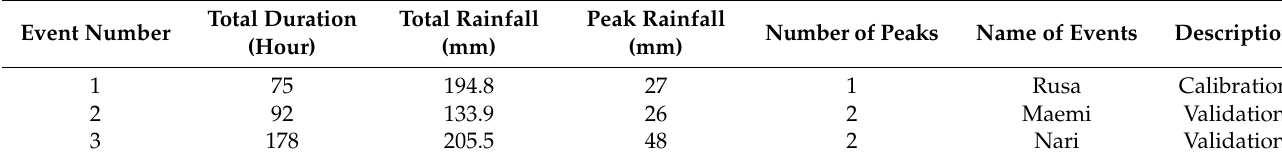
Table 2. Description of three storm events.